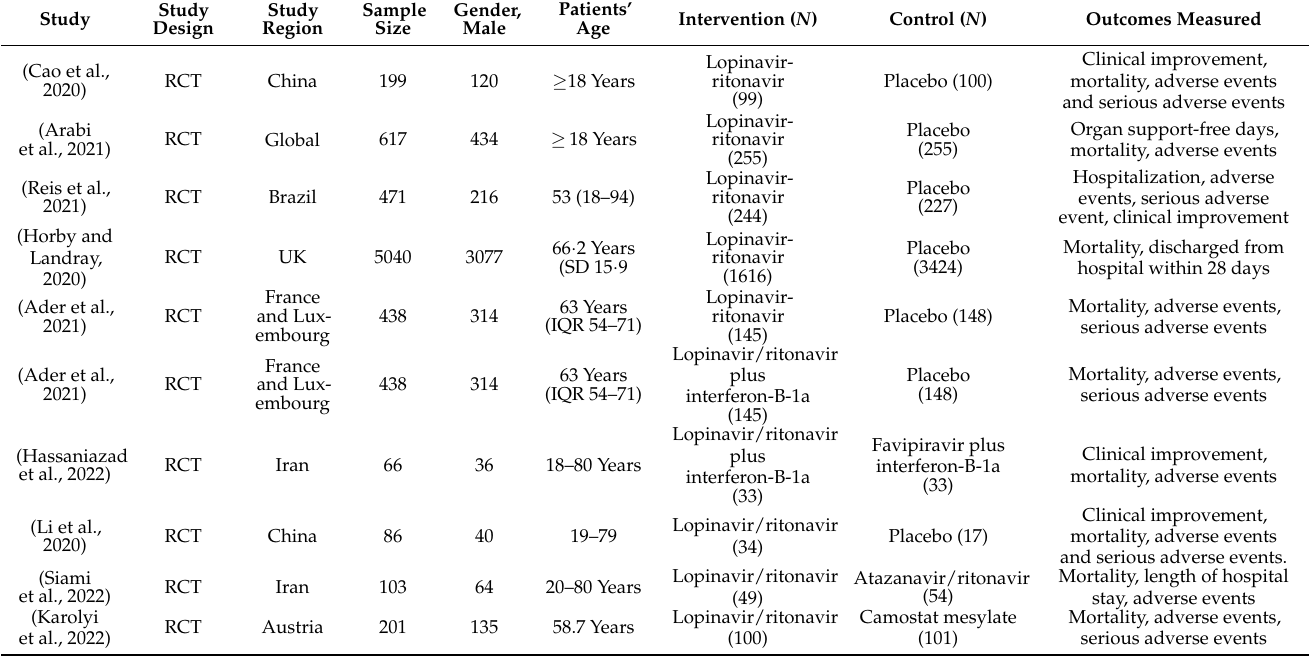
Table 1. Characteristics of included studies considered in this